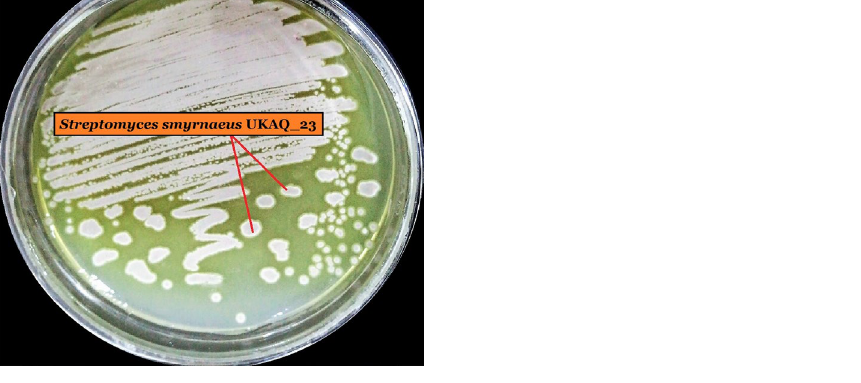
Figure 1. Growth of UKAQ_23 on modified International Streptomyces Project (ISP)-4 agar at 35 °C for 7